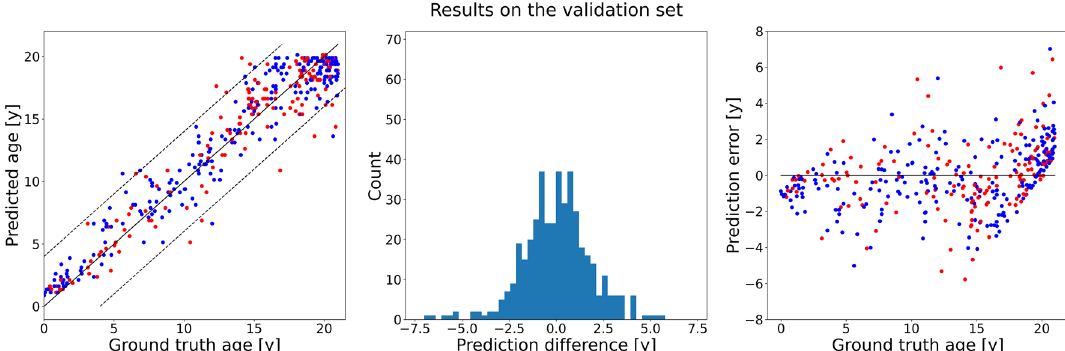
Figure 4. Results of the optimized network trained on the training set and evaluated on the validation set. Left : Scatter plot of the ground truth ages ( x -axis) against predicted ages ( y -axis). The dashed lines mark the limits at ± 4 years. Red dots correspond to female patients, blue dots to male patients. Middle : A histogram of the prediction errors. Right : Scatter plot of the ground truth age ( x -axis) against the prediction errors ( y -axis). Red dots correspond to female patients, blue dots to male patients.